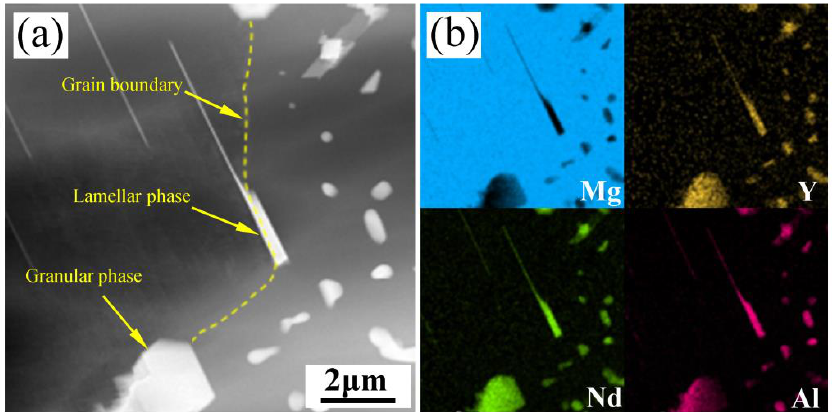
Figure 9. HAADF-STEM morphology and EDS mapping of Al 2 RE phase at the grain boundary of the Mg-3Y-4Nd-2Al alloy after solution treatment for 2 h: ( a ) HAADF-STEM morphology, ( b ) EDS mapping.